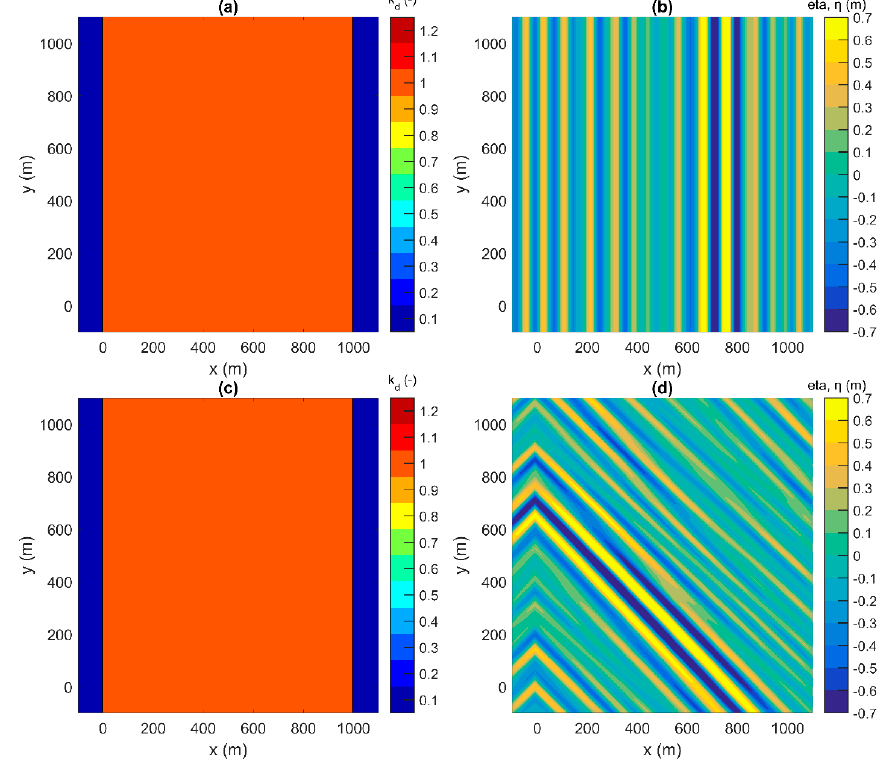
Figure 7. Disturbance coefficient, k d , and water surface elevation, η , in the inner computational domain at t = 7000 s for irregular long crested waves with H s = 1 m, T p = 12 s, and ( a , b ) θ = 0 ◦ and ( c , d ) θ = 45 ◦.